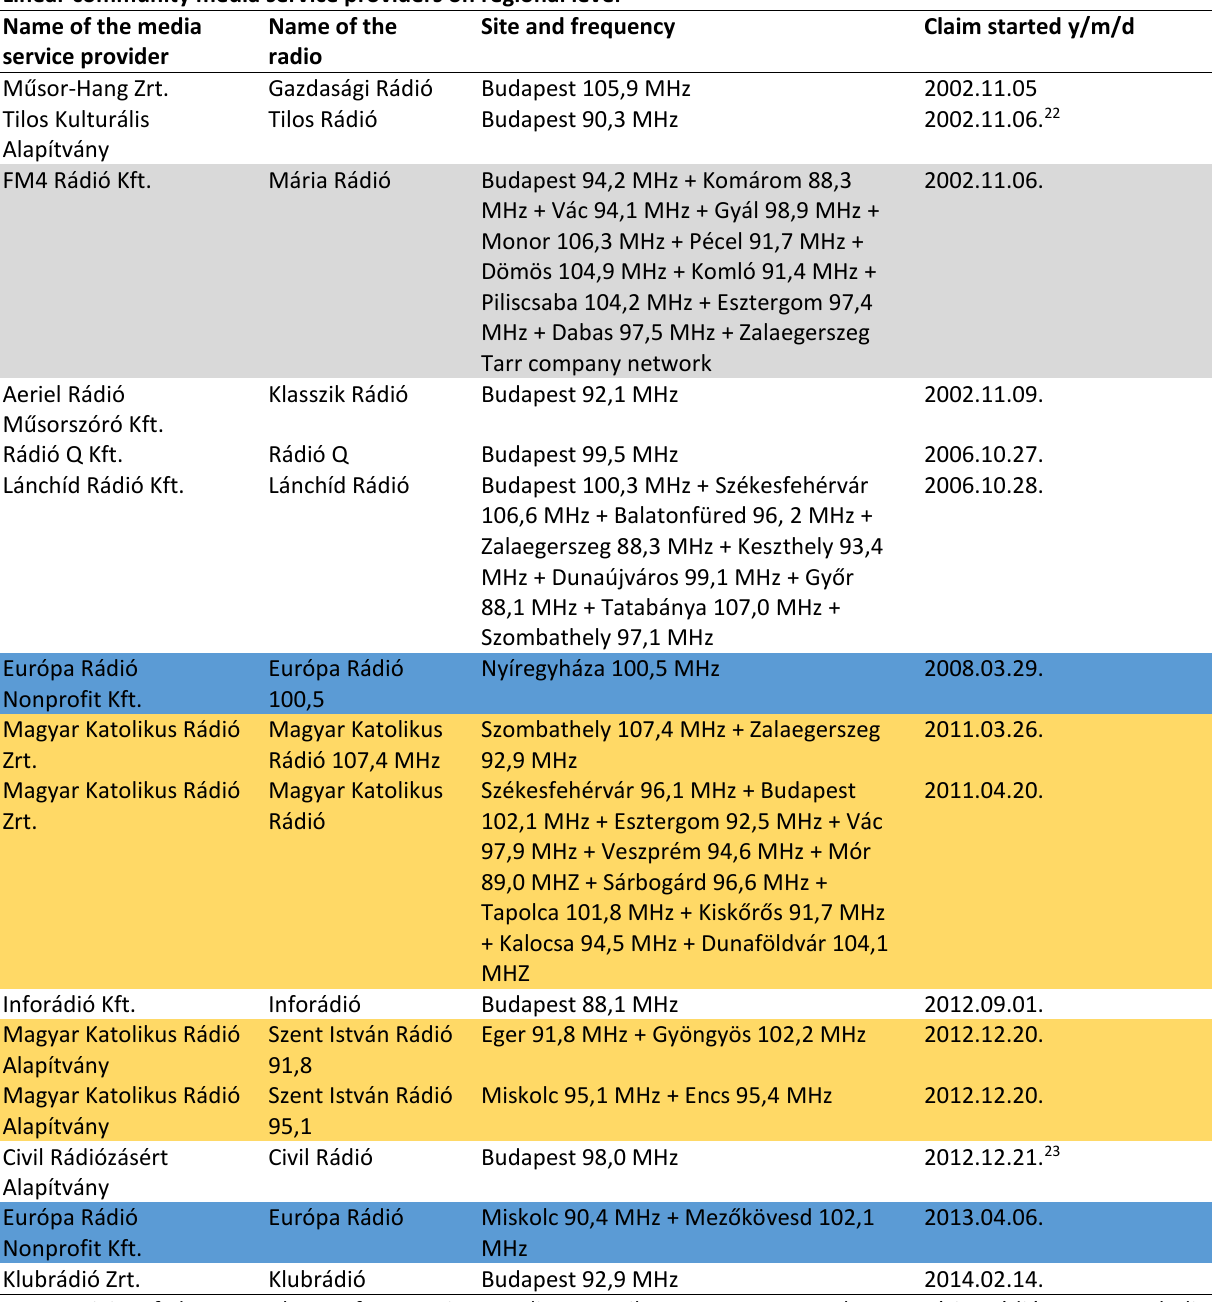
Table 1. Linear community media service providers on regional